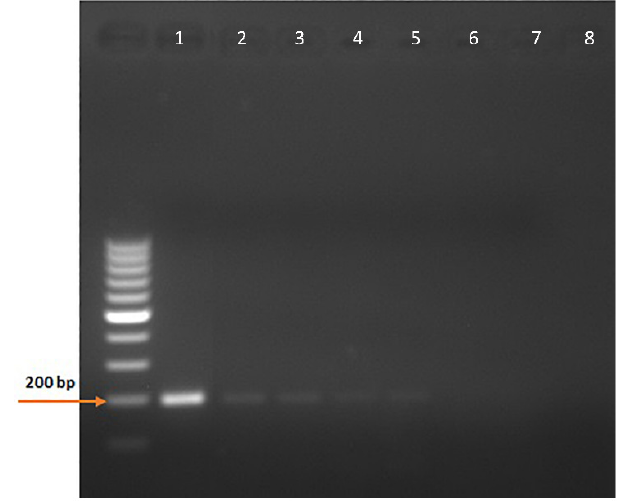
Figure 4. Minimum copy number detection for the nested PCR assay. Ten-fold dilutions of the pCDNA3.1-Pythium-ITS2 366-556 plasmid were used to determine the sensitivity of the nested PCR assay detecting the ITS2 366-556 sequences of P. insidiosum rDNA. 1, 5 × 10 2 copies; 2, 5 × 10 1 copies; 3, 5 × 10 0 copies; 4, 5 × 10 − 1 copies; 5, 5 × 10 − 2 copies; 6, 5 × 10 − 3 copies; 7, 5 × 10 − 4 copies; 8, No template.